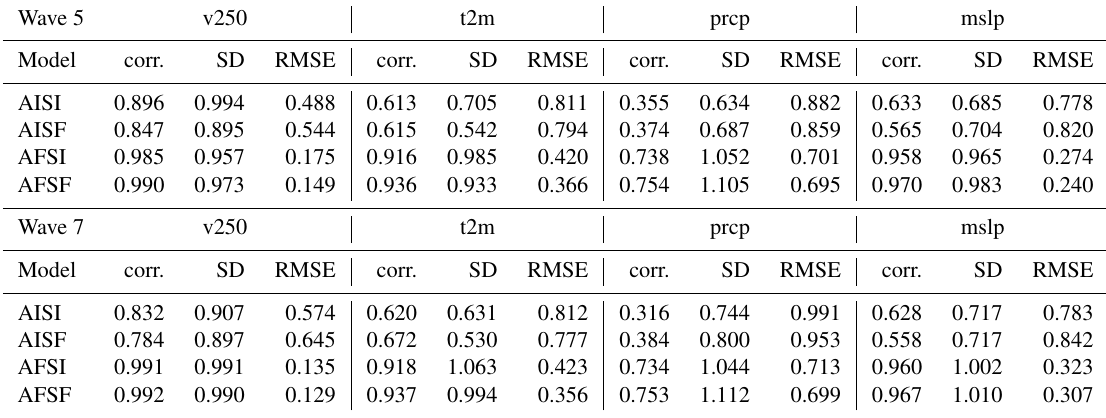
Table A4. Summary of multi-model mean Taylor diagram values (corr.: correlation).